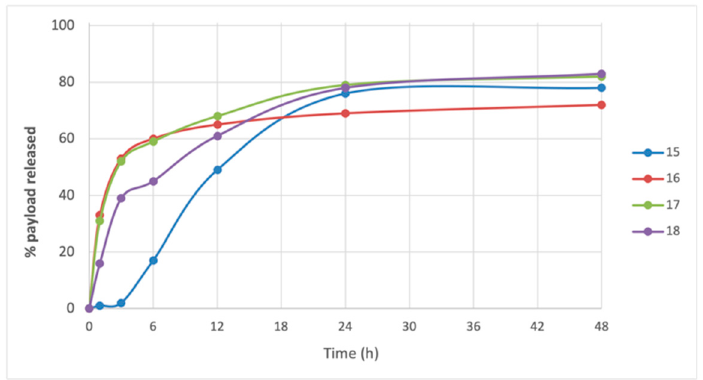
Figure 1. Qualitative analysis of payload release of acylamido carbamates 15 – 18 . Release conditions are reported in the Materials and Methods section and in Supplementary